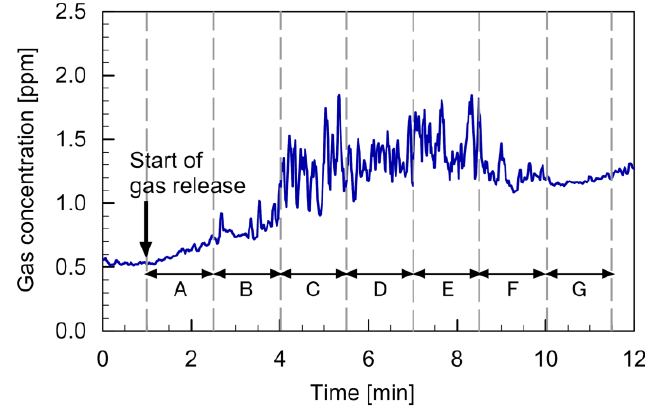
Figure 8. Time course of the PID reading observed when the gas source was moved from point A to point G.